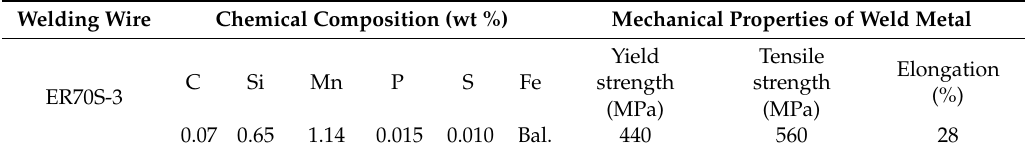
Table 2. Chemical composition and mechanical properties of the welding wire.